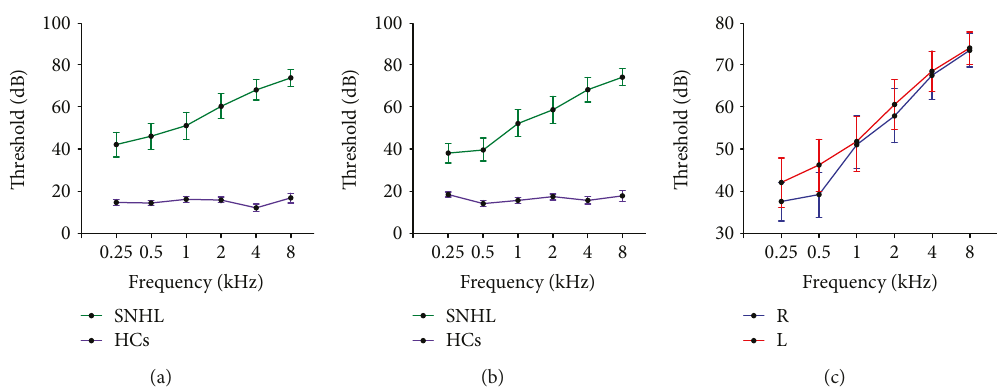
Figure 1: Pure tone audiometry (PTA) test of the long-term bilateral moderately severe sensorineural hearing loss (SNHL) patients and healthy controls (HCs). (a) Mean ( ± SEM) PTA of right ears of the SNHL group and HCs. Compared to HCs, thresholds are signi fi cantly higher in right ears of the SNHL group at 0.25, 0.5, 1, 2, 4, and 8kHz, p < 0 001 . (b) Mean ( ± SEM) PTA of left ears of the SNHL group and HCs. Compared to HCs, thresholds are signi fi cantly higher at every frequency, p < 0 001 . (c) There was no signi fi cant di ff erence between left and right ears in long-term bilateral SNHL subjects, p > 0 05